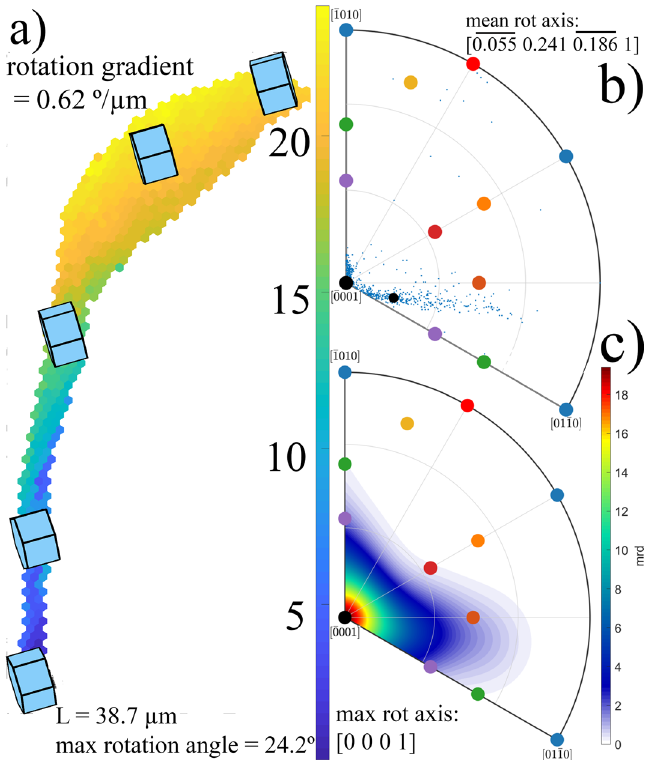
Figure 3. Misorientation analysis in an individual fiber; ( a ) misorientation angle map of one vertical fiber in the right spherulite on Fig. 1b. Color denotes the misorientation angle, between a local point and the lowest fiber point (close to spherulite nucleation orientation). The local Quartz lattice orientation is shown in a few points. ( b ) Rotation axis directions observed between the lowest point and all other points in the fiber. The mean rotation axis direction is shown by a small black circle. ( c ) Calculated rotation axis distribution. The distribution maximum is located in the [0001] direction. Rotation axes of all common slip systems from Fig. S1c and Table S1 from “SI” are also marked in both